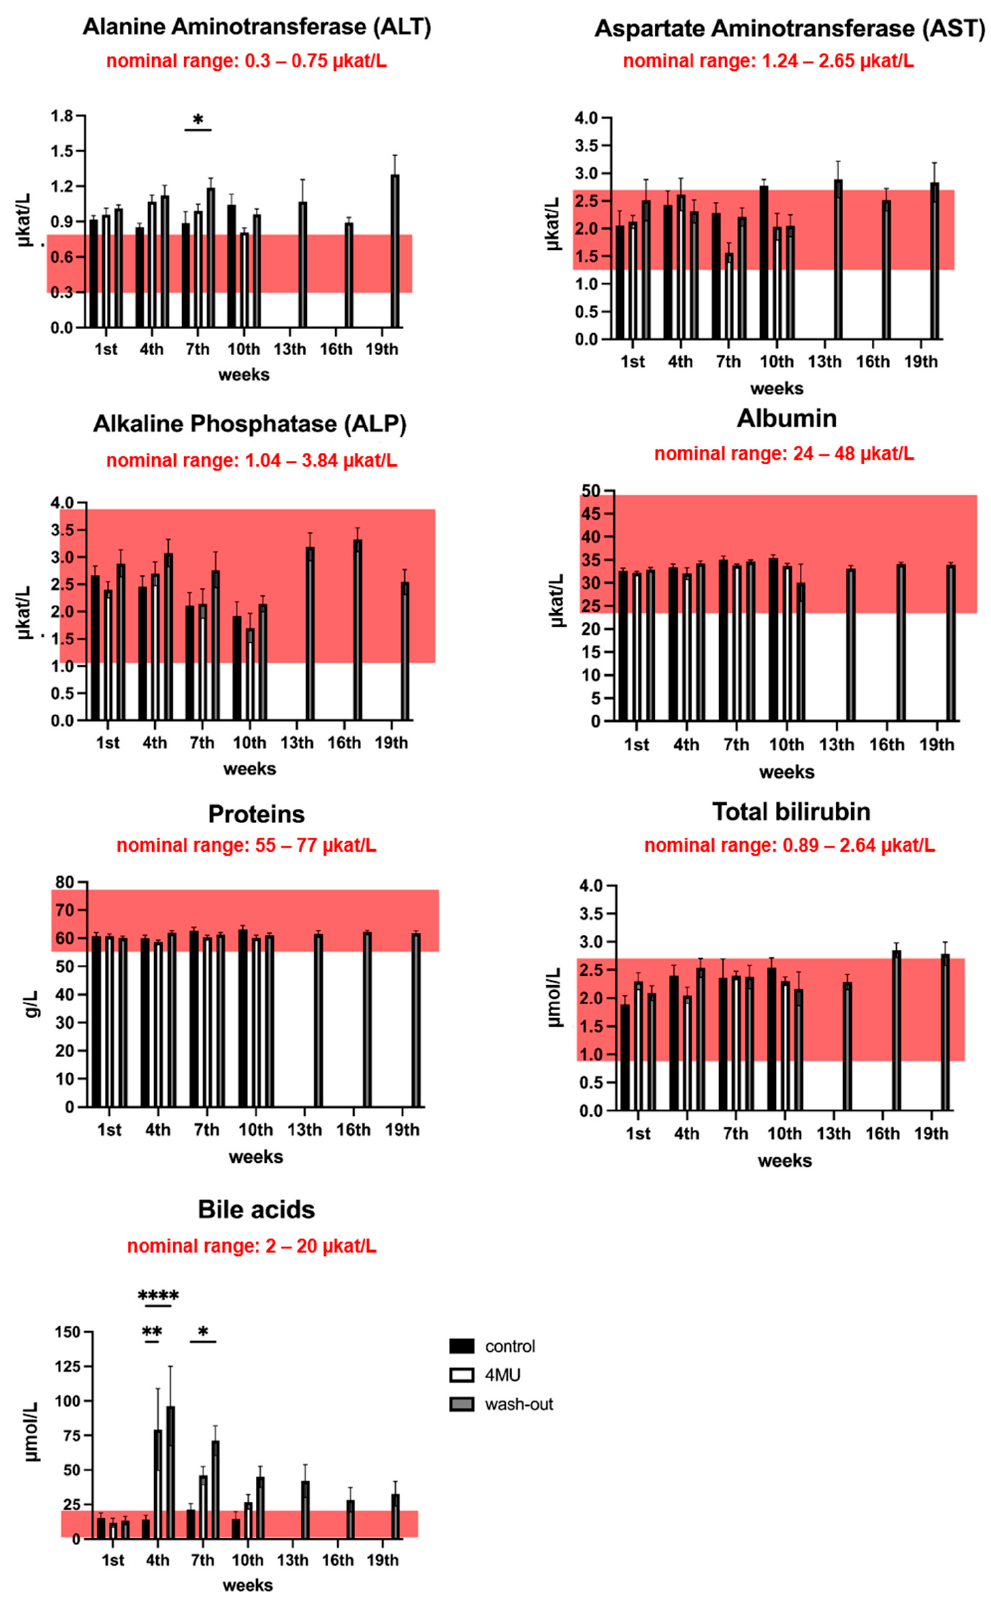
Figure 3. Liver function tests do not indicate any liver damage after long-term 4MU treatment at 1.2 g/kg/day dose. The pink box in each graph indicates the nominal range of the corresponding test. * p < 0.05, ** p < 0.01, **** p < 0.0001 by two-way ANOVA with Tukey’s multiple comparisons test, n = 5 to 7. 4MU has been shown to increase bile acid secretion and is used in biliary stasis [18].